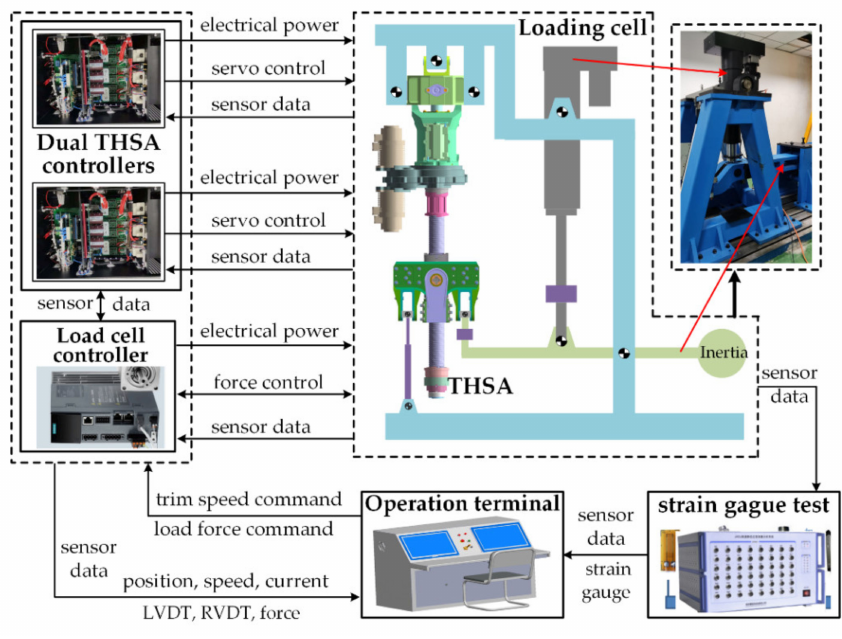
Figure 7. Test rig for